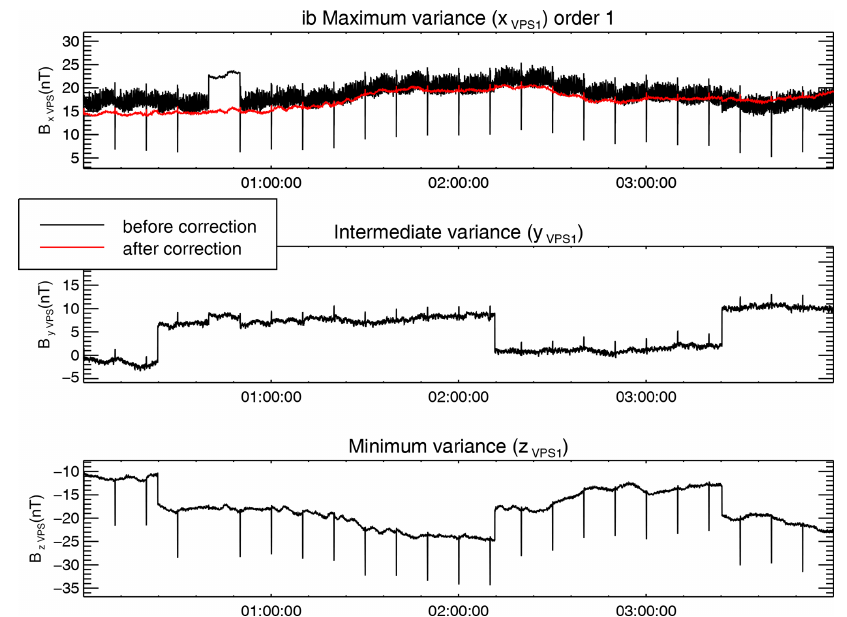
Figure 4. The initial AMR1-corrected FGM inboard measurements represented in the inboard VPS are plotted with the black lines. The first-order correction is plotted with red. Mean values were subtracted.